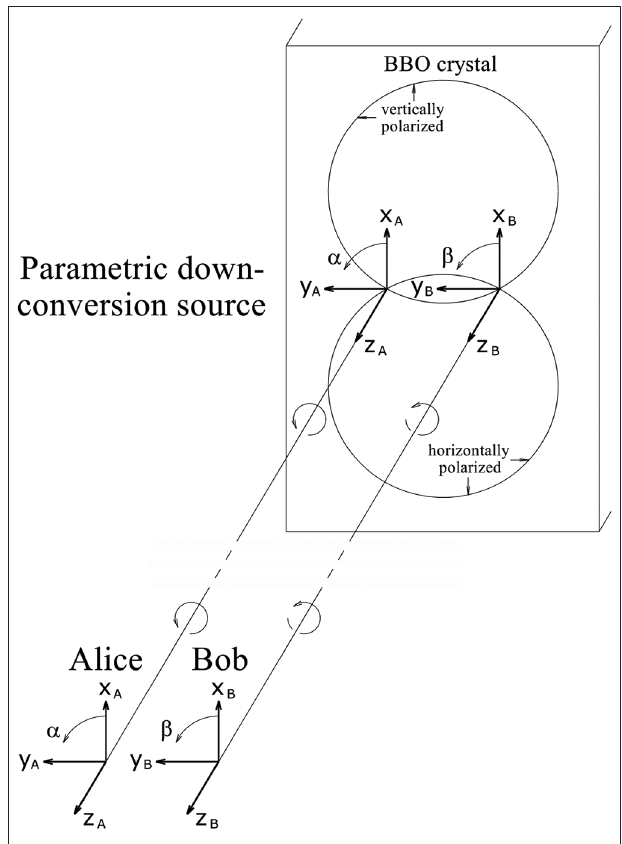
FIGURE 1 | Schematic diagram of a simple experimental setup suited to determine polarization correlations. In the top right corner a BBO source is shown which provides entangled photons both rotating in the same direction. The coordinate systems of the observers Alice and Bob shown in the bottom left corner are both right-handed. The angles α and β indicate the orientations of the linear polarizations looked for by Alice and Bob, respectively. The thin lines between source and observers denote optical fibers. The distance between Alice and Bob is usually chosen large enough to ensure that two associated photon detection processes are spacelikely